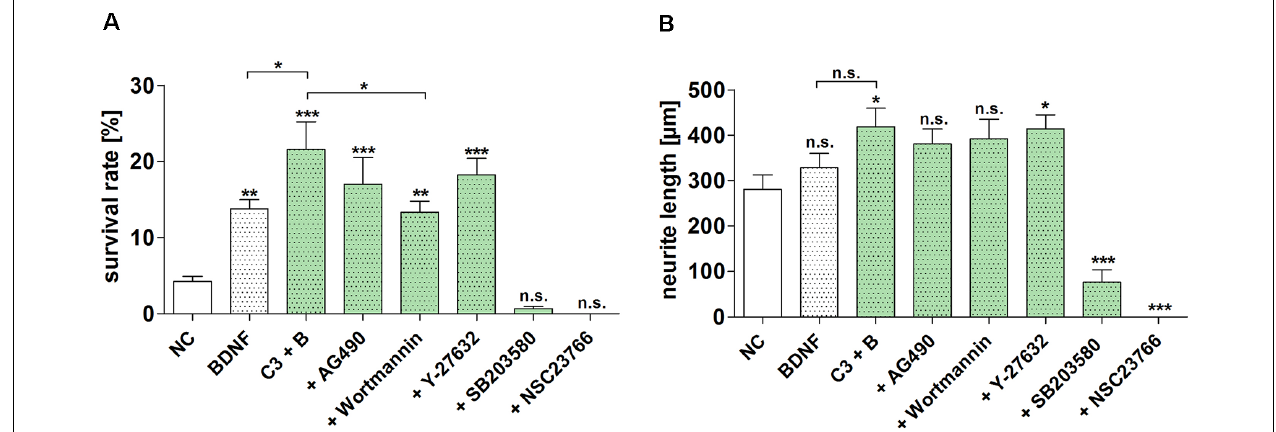
FIGURE 5 | Inhibition of the neuroprotective effect of different C3 constructs on SGN. The determined survival rate and measured neurite length of SGN treated with C3 wild-type in combination with BDNF and different selected inhibitors for 48 h are depicted. (A) Treatment with C3 plus BDNF significantly increased the survival rate of SGN in comparison to the negative control and BDNF alone. Additional application of wortmannin significantly decreased the survival rate when compared to C3/BDNF treatment alone. The inhibitors SB203580 and NSC23766 significantly decreased the survival rate and neurite length of SGN after the treatment with C3 wild-type in combination with BDNF. (B) The measured neurite length of SGN was significantly increased after the treatment with C3 plus BDNF and C3 plus BDNF in combination with Y-27632 when compared to the negative control. Asterisks over the error bars indicate the respective significance to the NC. NC, negative control; C3, 50 nM; BDNF/B, brain-derived neurotrophic factor, 50 ng/ml; SGN, spiral ganglion neurons (SGN); n.s., not